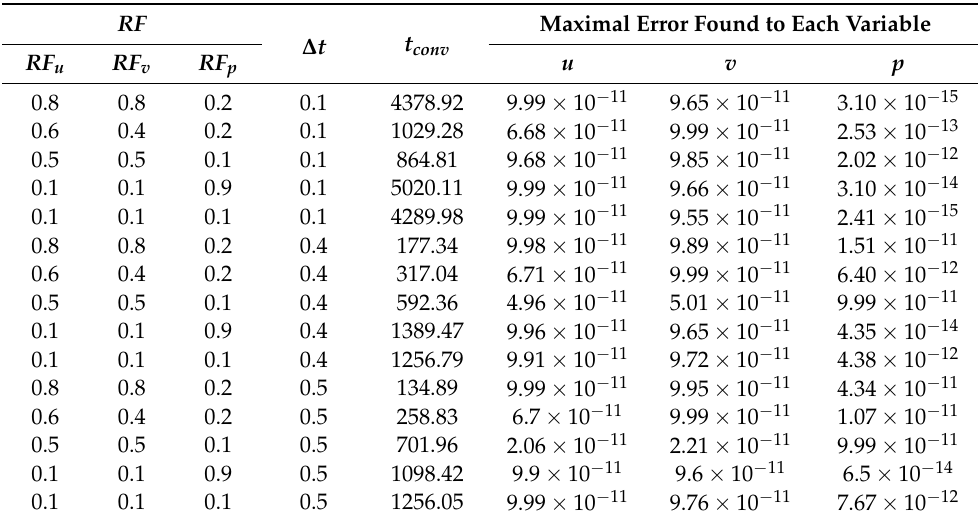
Table 7. Relaxation factors ( RF) and ∆ t variation and errors obtained with a 61 × 61 mesh. RF ∆ t t conv